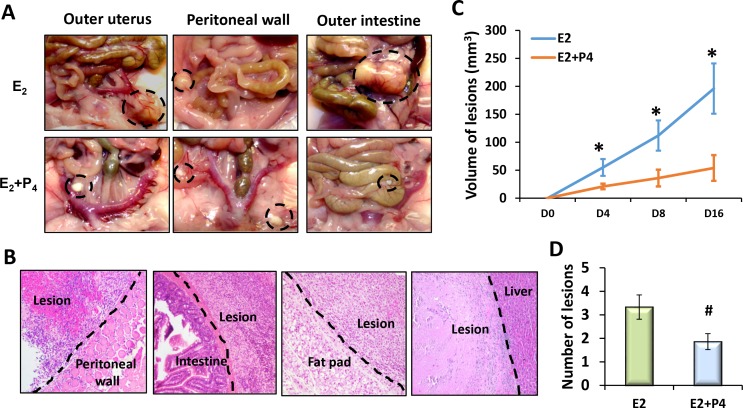
P4 alleviates E2-dependent establishment and growth of ectopic lesions.Ectopic lesions were established in the peritoneal cavities of immunocompetent female mice and treated with E2 or P4 along with E2 as described in Fig 1 (N = 6). (A) Locations of ectopic lesions (Dashed circles). (B) Histology of ectopic lesions. Dashed lines indicate the contact sites of the ectopic lesions with adjacent peritoneum. Representative images of ectopic lesions harvested at four weeks after induction are shown (40X). (C) Time-course progression of ectopic lesions. The average volumes of the ectopic lesions at the indicated time points are shown. (D) The average numbers of ectopic lesions identified in each treatment group are shown. The numerical values were analyzed by One-way ANOVA followed by Dunnett’s post hoc test and expressed as mean ± SEM. Statistical significance is defined as #: p < 0.05, *: p<0.01.